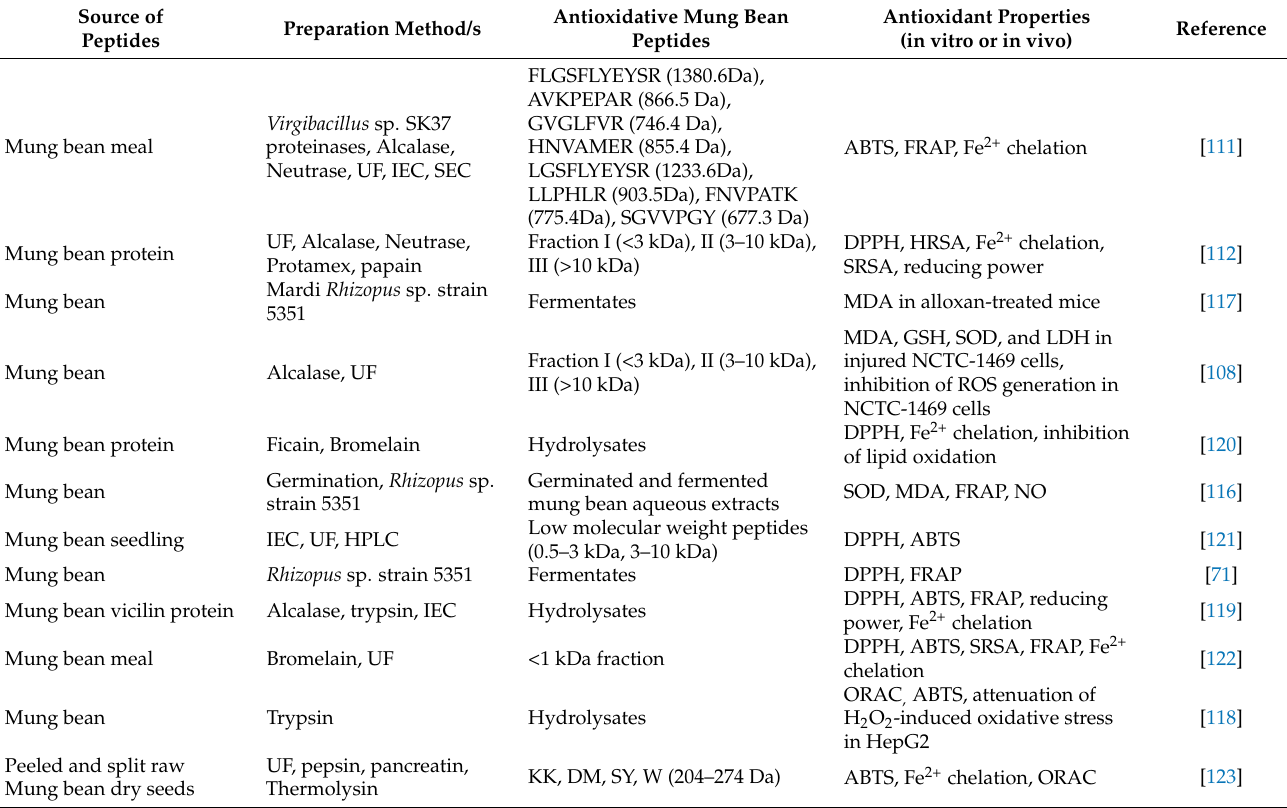
cells in addition to antioxidant and ACE inhibitory activities [119]. Table 5. Antioxidant properties of mung bean-derived hydrolysates and